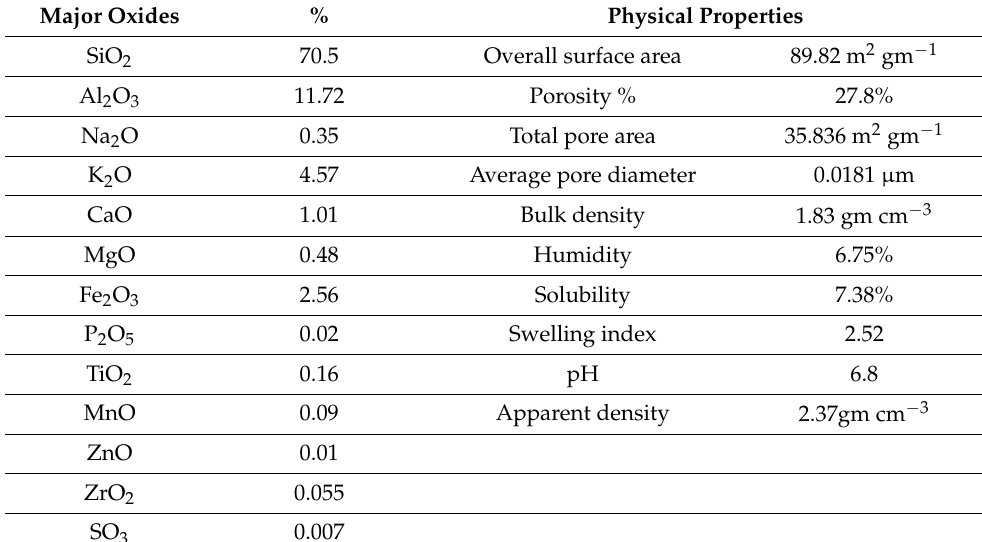
Table 2. Chemical composition and physical properties of natural zeolite sample